Question: Draft a figure caption describing what is shown.
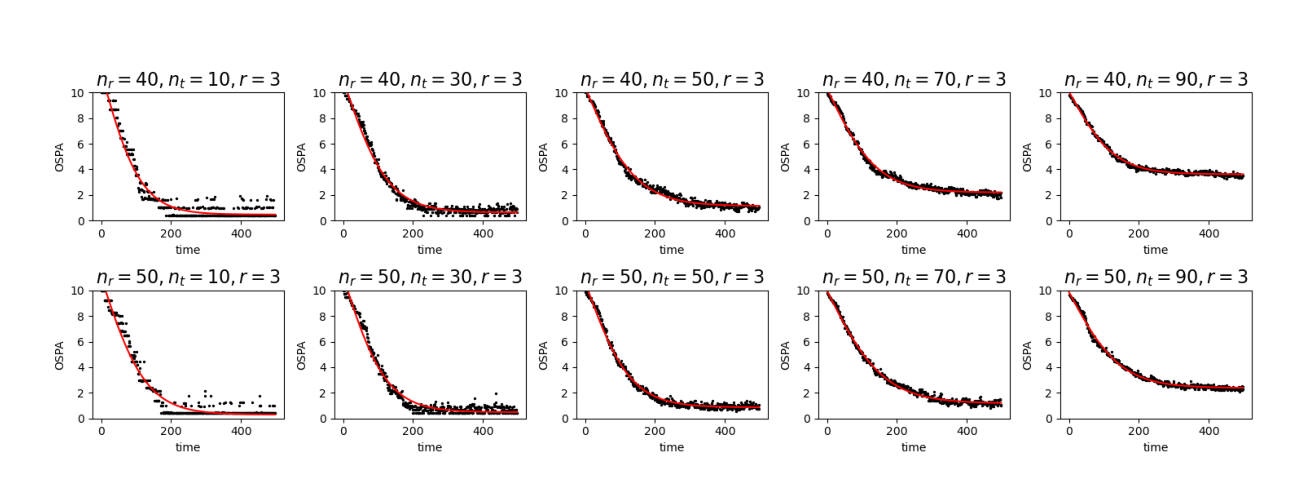
Answer: The black points represent the median OSPA value from the dataset with a batch size of 10 over time. The red lines illustrate the fitting results using a sigmoid function.